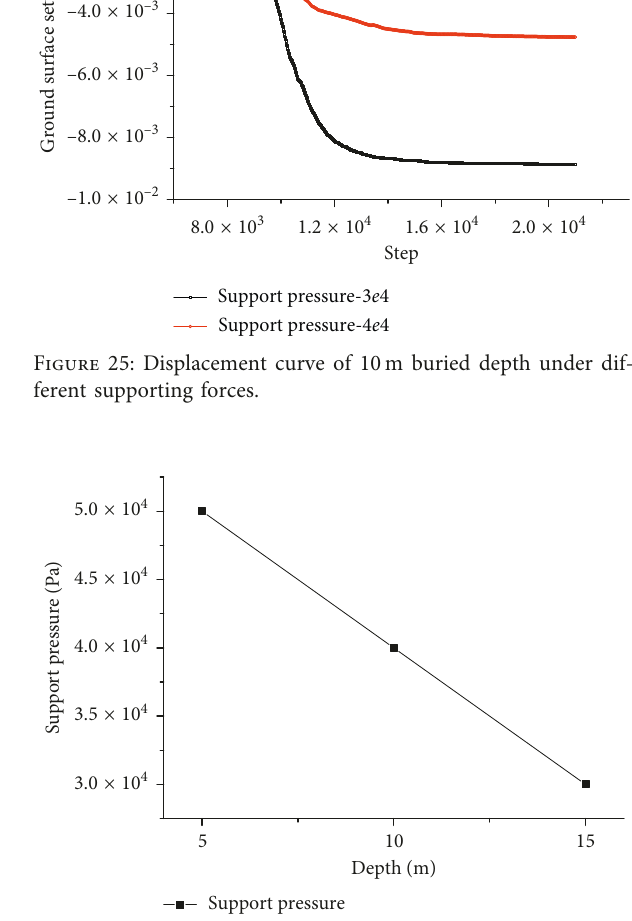
Figure 26: Minimum support force at different depths in con- trolling surface